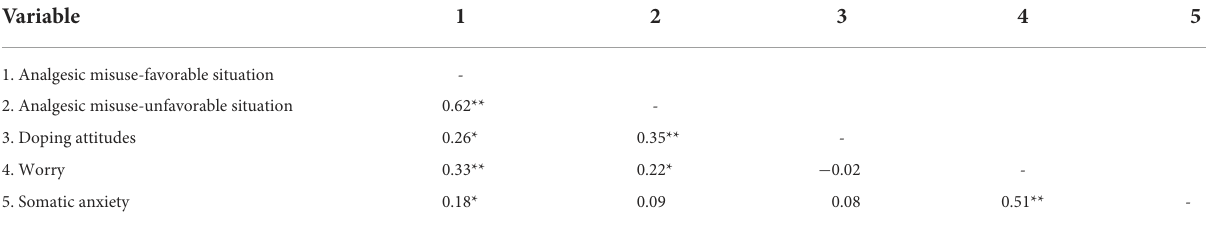
TABLE 2 Bivariate Pearson correlations of the predictors and outcome variables.